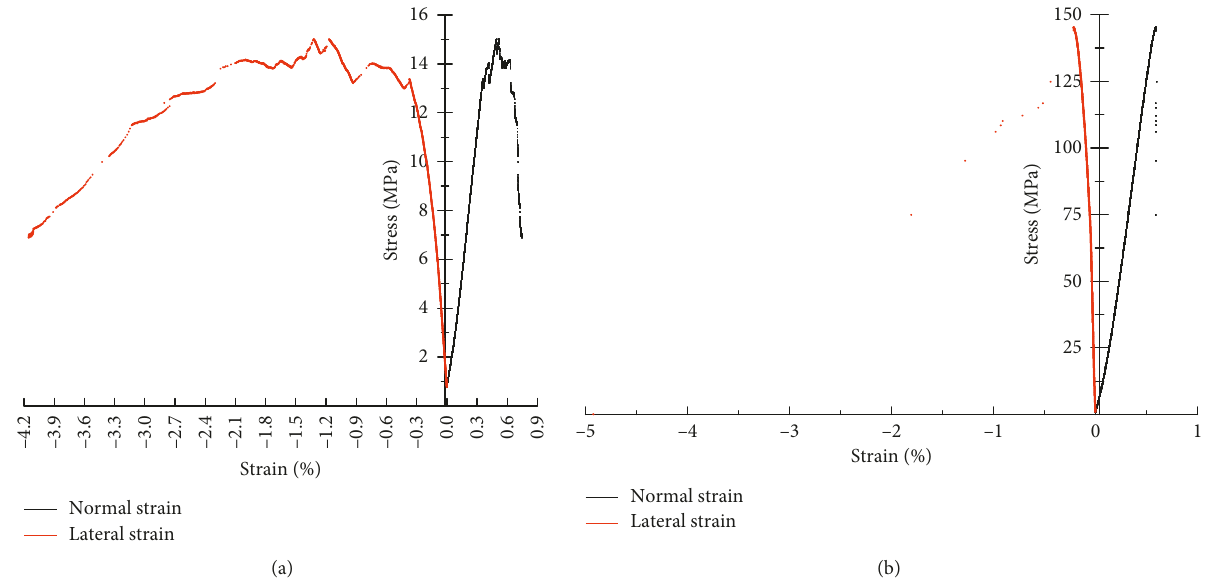
Figure 2: The stress-strain curves of individual coal and rock samples: (a) coal sample; (b) rock sample.